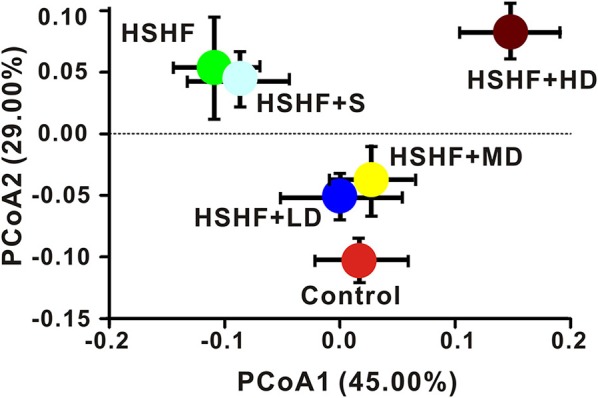
Dose-dependent change in the composition of mice fed the HSHF diet and treated with different krill oil doses via Weighted Unifrac PCoA analysis. Data are presented as the means ± S.D.